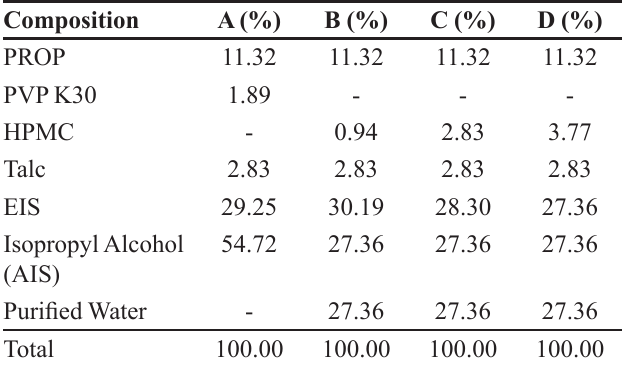
TABLE III - Factorial 2² planning for the codified